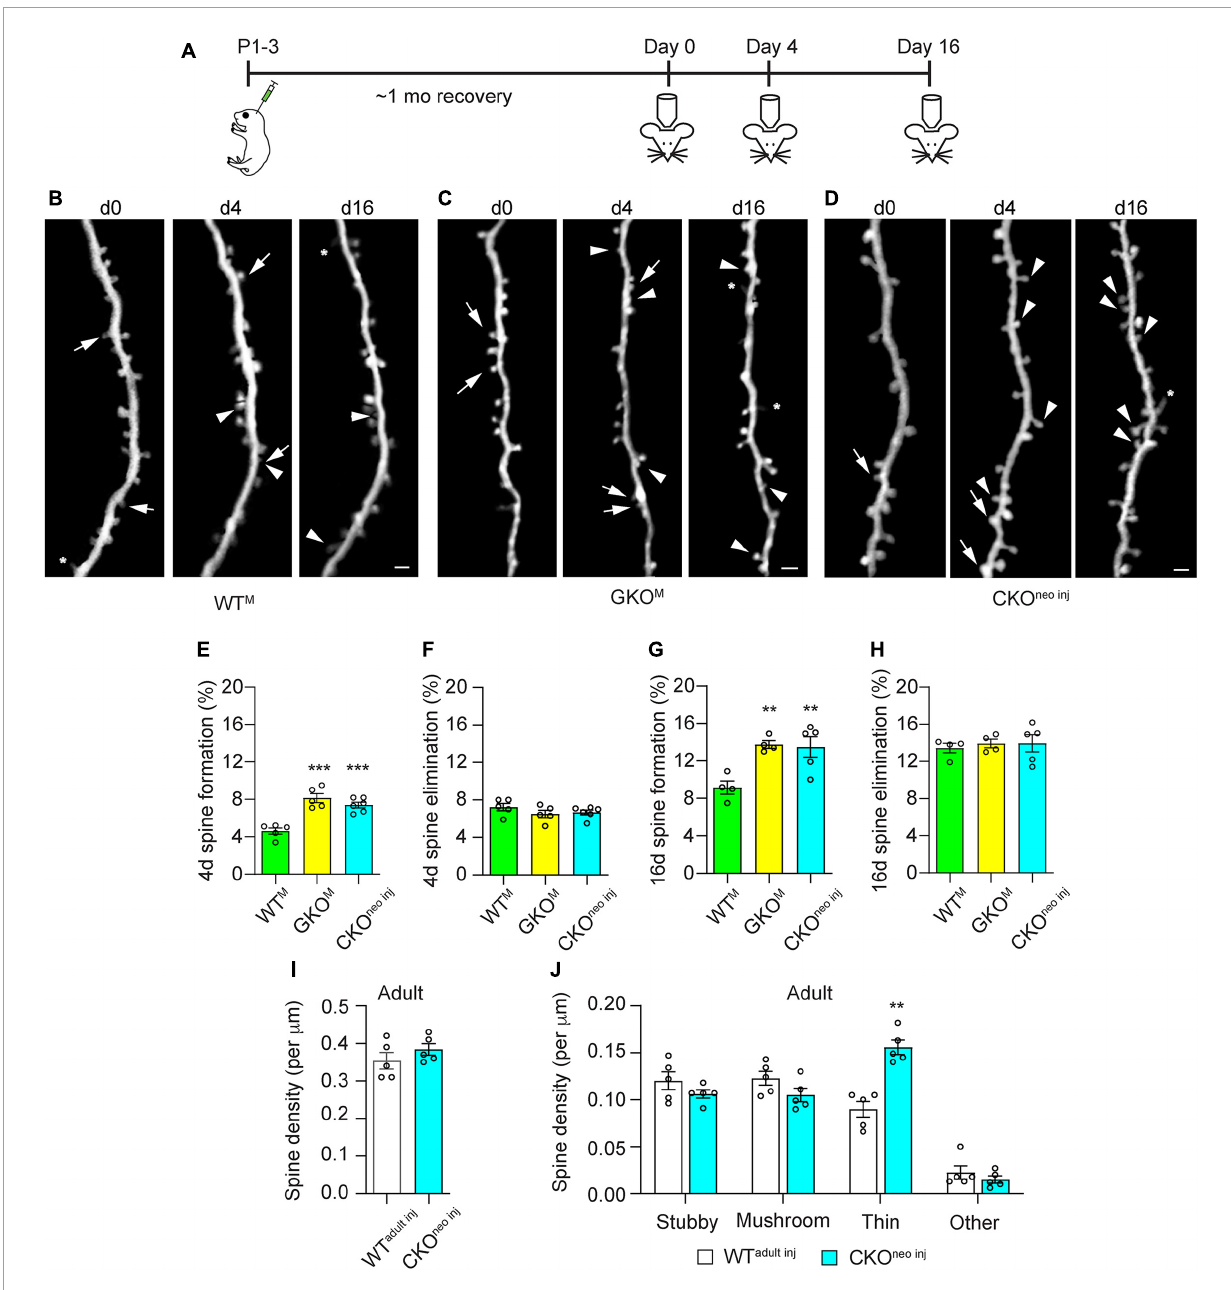
FIGURE4 Cell-autonomous Fmr1 knockout (KO) in adolescence selectively affects spine formation but not elimination. (A) Timeline of virus injection and in vivo two-photon imaging. (B–D) Examples of spine formation and elimination in adolescent WT M (B) , global knockout (GKO M ) (C) , and conditional knockout (CKO neo inj ) (D) mice. Arrows: eliminated spines; arrowheads: formed spines; asterisks: filopodia. Scale bar = 2 µ m. (E,F) Spine formation (E) and elimination (F) rates over 4 days in WT M , GKO M , and CKO neo inj mice. n = 5 mice for WT M and GKO M , and six mice for CKO neo inj . (G,H) Spine formation (G) and elimination (H) rates over 16 days in WT M , GKO M , and CKO neo inj mice. n = 5 mice per group. (I) Total spine density in WT adult inj and CKO neo inj mice at adulthood. n = 5 mice per group. (J) Density of different types of spines in WT adult inj and CKO neo inj mice at adulthood. n = 5 mice per group. ** p < 0.01, *** p < 0.001.